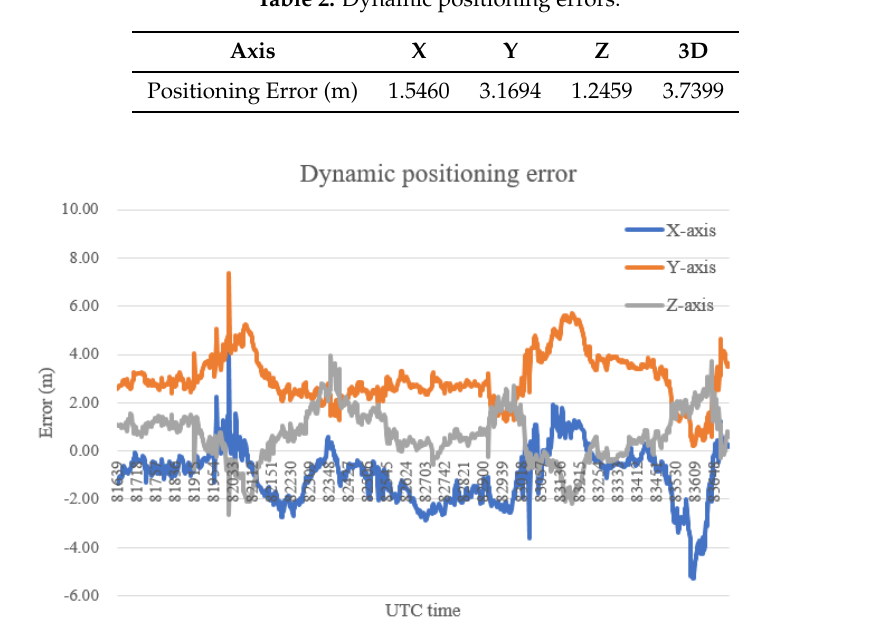
Figure 9. The dynamic positioning error.